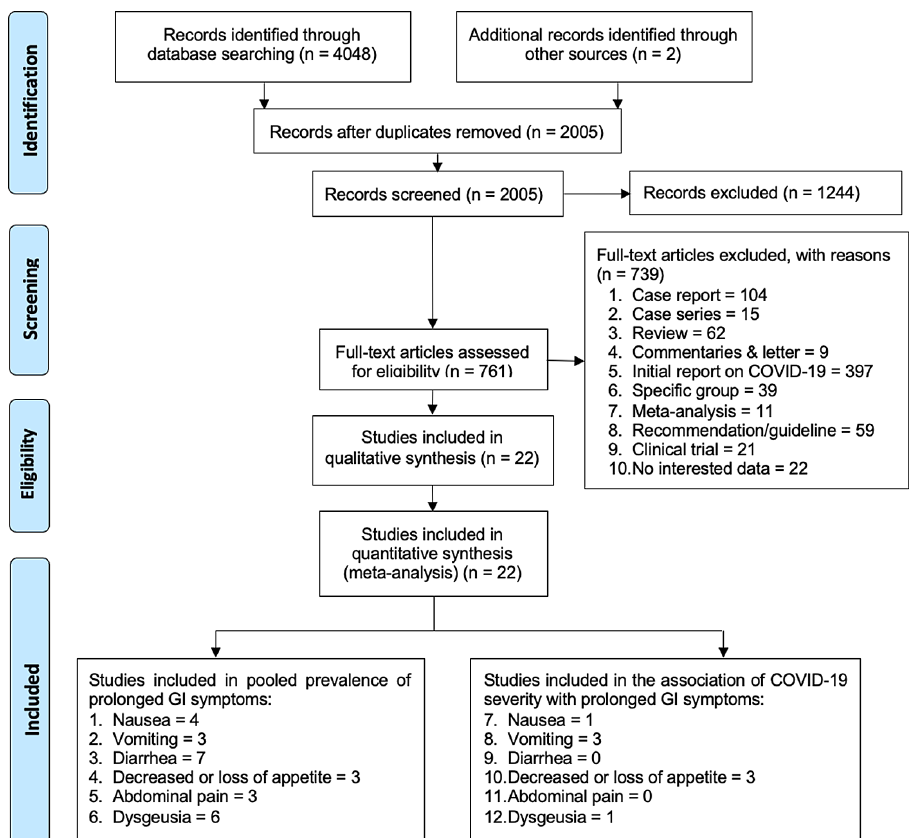
Figure1.FlowchartoftheresultofliteraturesearchaccordingtothePreferredReportingItemsofSystematic Reviews and Meta-Analyses